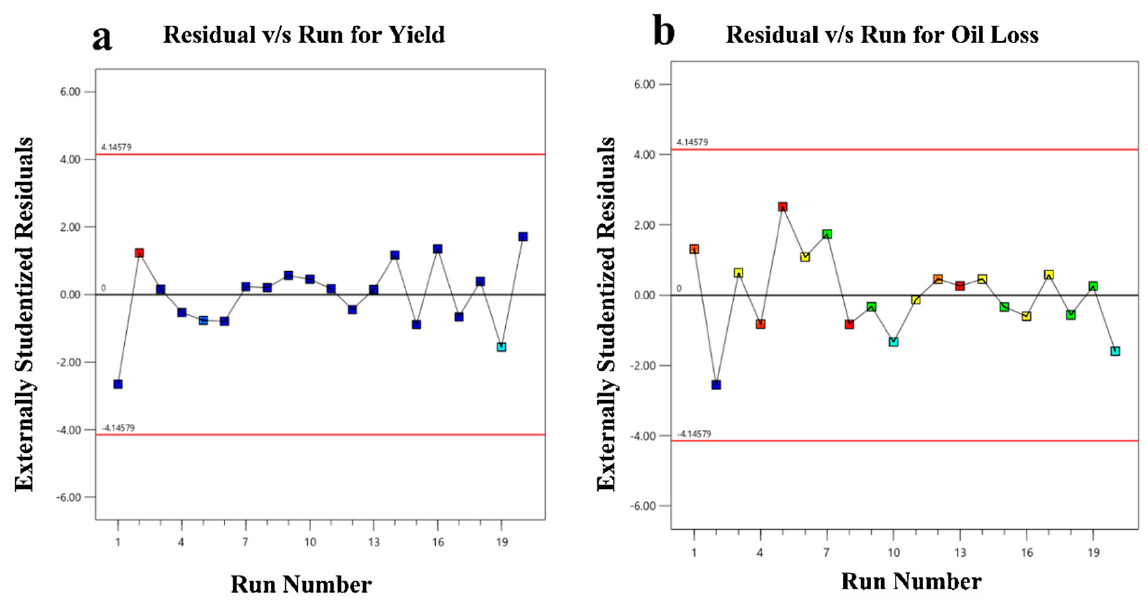
Figure 7. Residual v/s Run plots for ( a ) ricinoleic acid yield diagnostic; ( b ) oil loss diagnostic. The effect of the model is displayed and contrasted with the null model in a predicted versus actual graph. The points should be around the fitting line, with little confidence